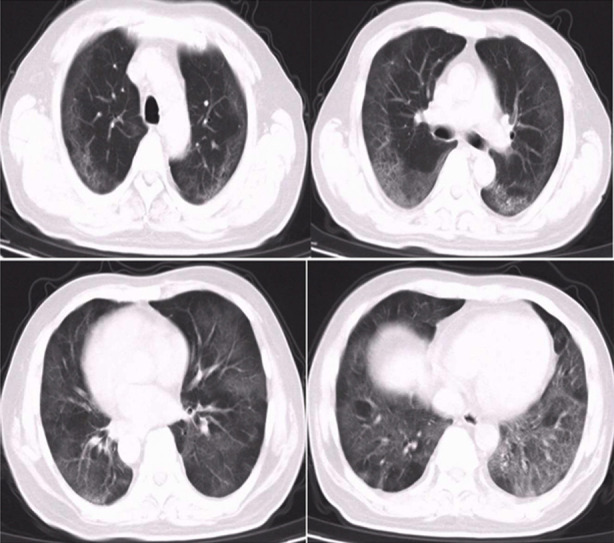
Chest CT scan results of a 53-year-old COVID-19 patient admitted after fever for 4 days. At admission, there were multiple ground-glass changes in both lungs. D-dimer level was 5.56 μg/ml, and hs-CRP level was 22.2 mg/L. He was given antiviral, immunity-enhancing and anticoagulant therapies.